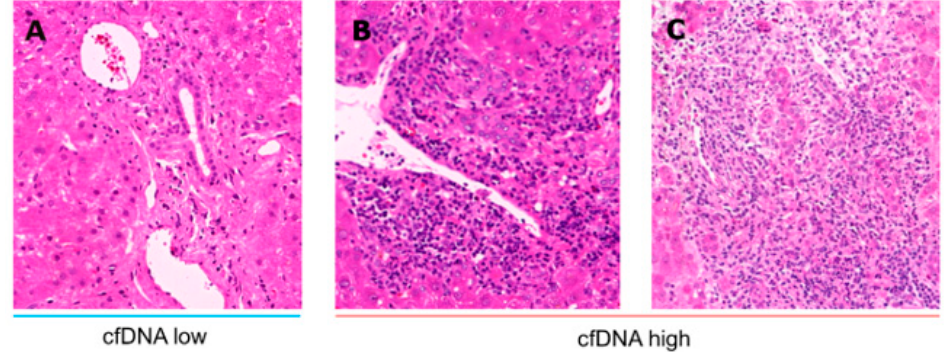
Figure 5. Representative liver biopsies for patients with high ( A ) and low ( B , C ) cfDNA levels. Liver biopsies were evaluated based on haematoxylin and eosin staining. Patients with high levels of cfDNA displayed florid portal inflammation and interface hepatitis. Samples with acute cellular rejection >BANFF 1 were excluded from the analysis.